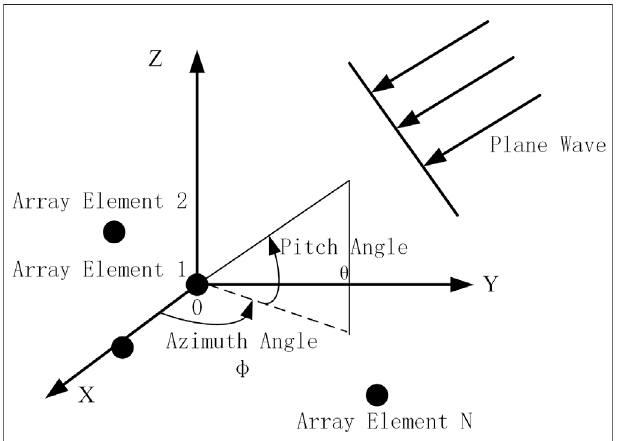
FIGURE 1 | Schematic diagram of antenna array and incident signal.